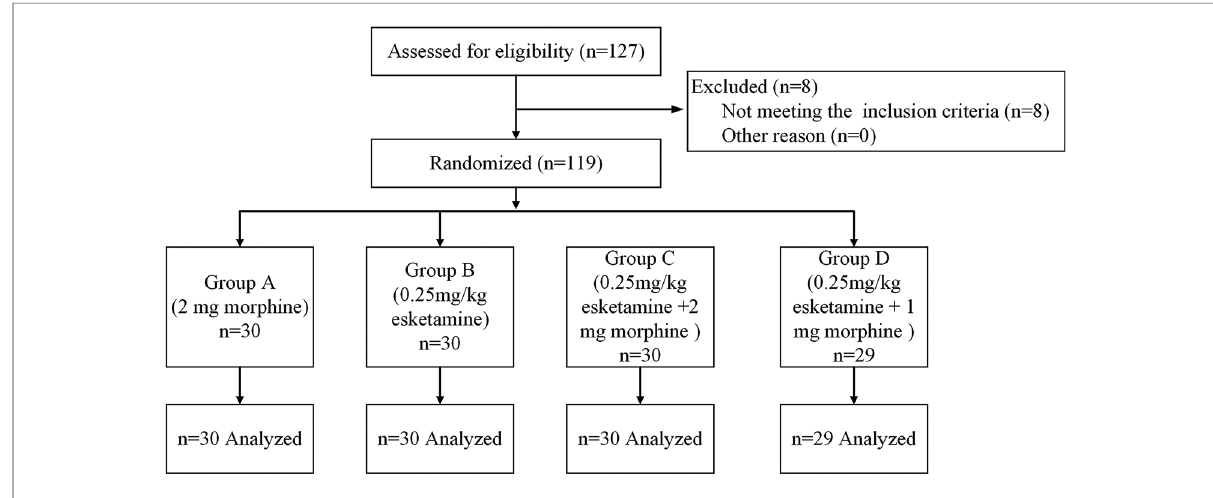
FIGURE 1 Flow diagram of all patients included in the four study